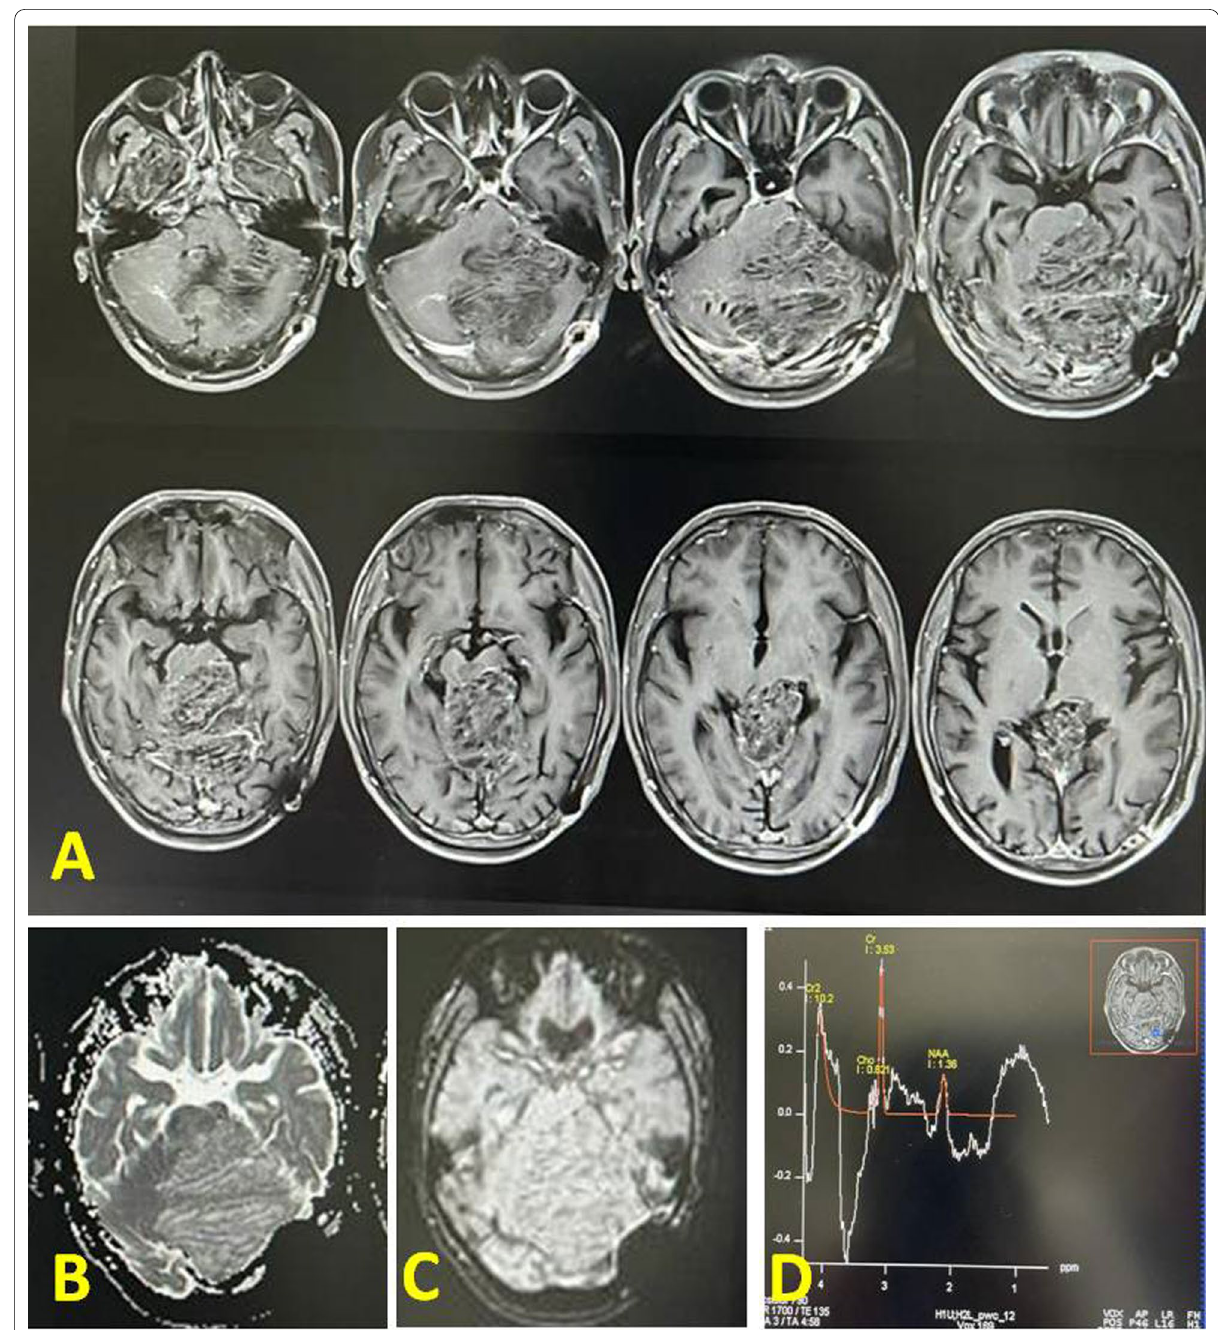
Fig. 3 MRI Characteristics of the lesion. a After contrast administration, multiple linear enhancing streaks were seen inside the lesion and at its periphery. b No diffusion restriction on DWI, c no blooming on SWI, d MR Spectroscopy shows decreased choline and NAA peaks